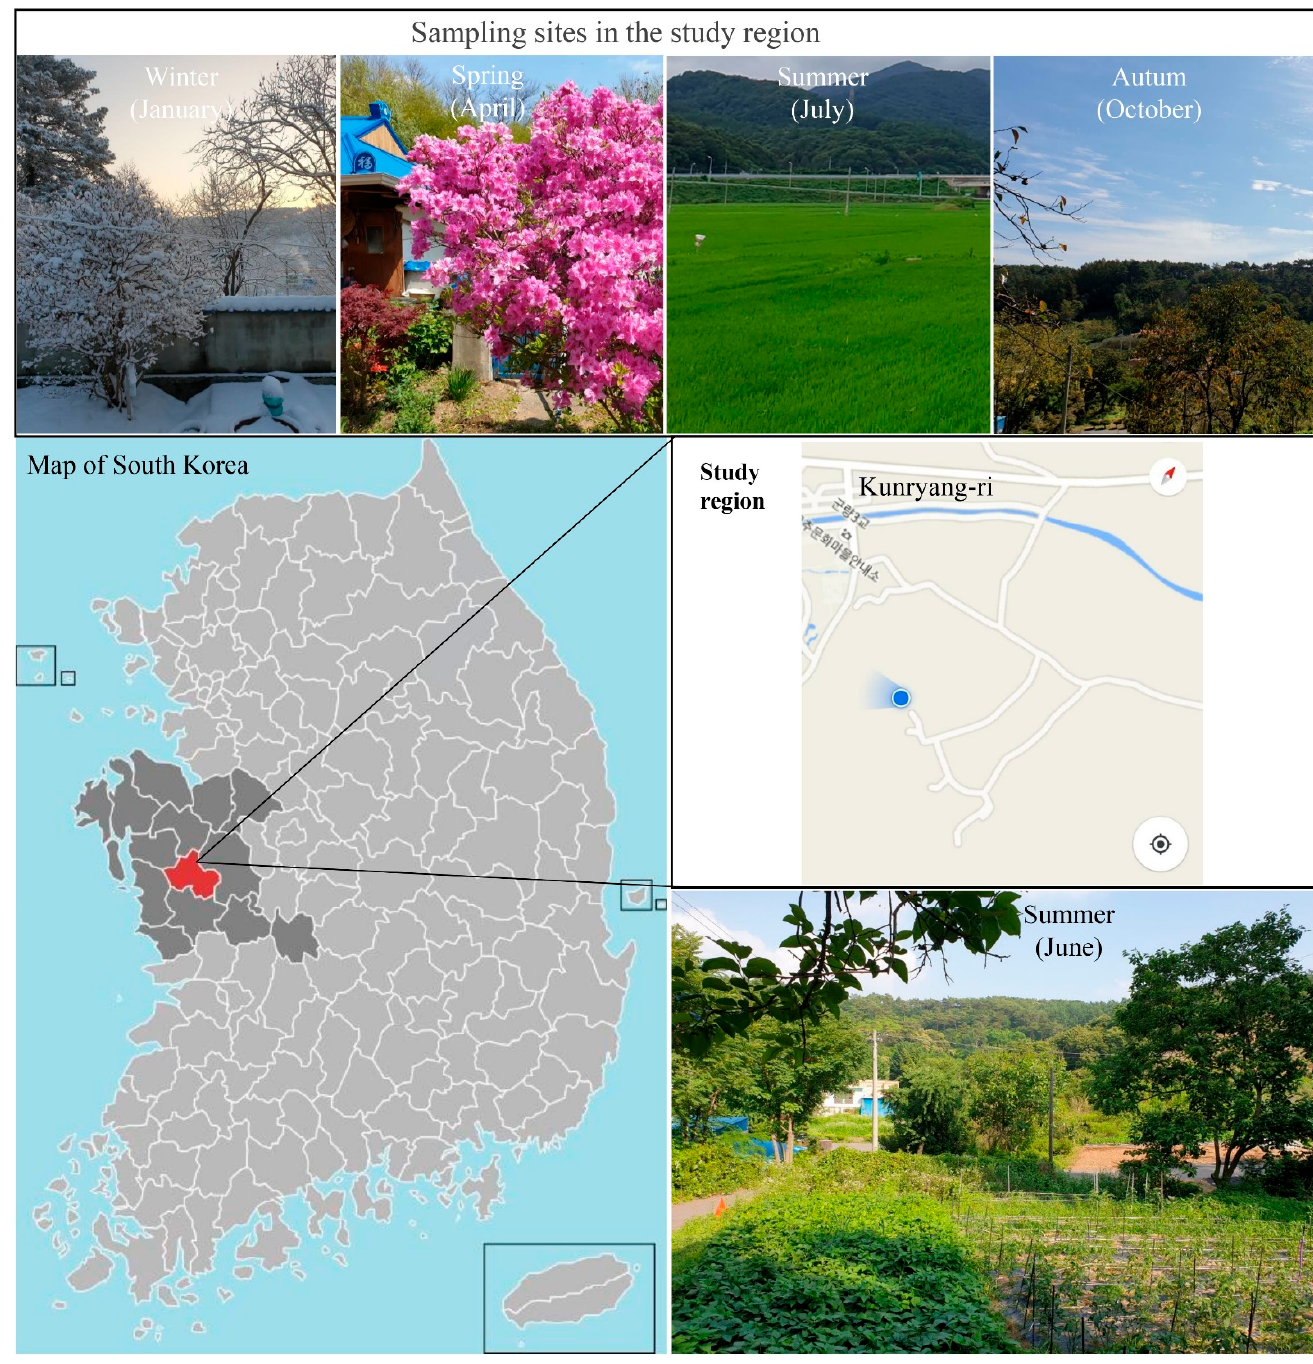
Figure 1. Map of sample collection sites. Samples were collected at Kunryang-ri, Cheongyang-eup, Cheongyang, Chungnam Province, Korea. Blue cursor represents the main area of Kunryang-ri for collection.